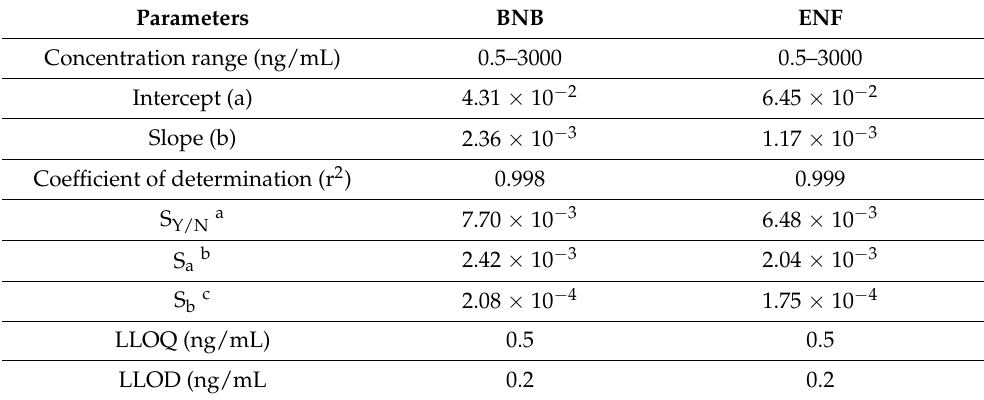
Table 2. Statistical parameters of calibration curves for ENF and BNB in rat plasma using the developed LC–MS/MS